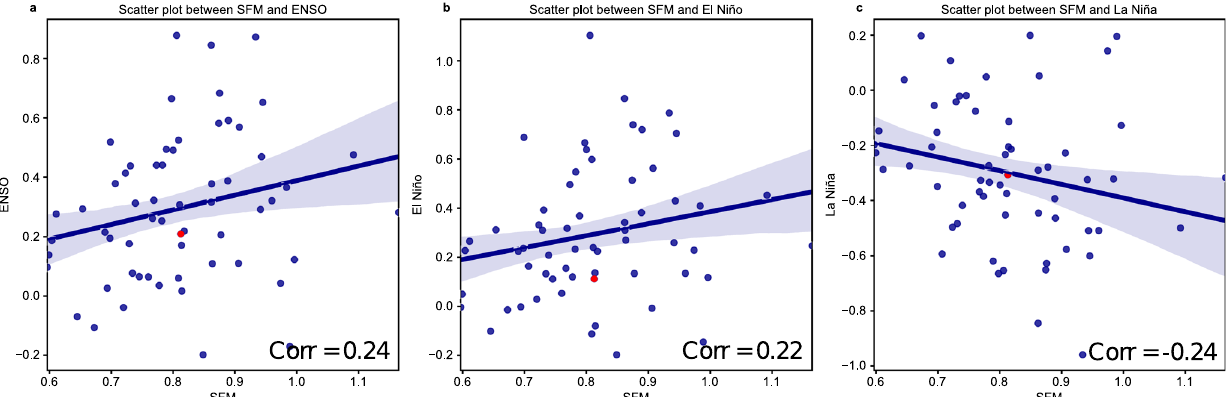
Fig. 11 Intermodel relationship between Niño3.4 index and SFM index for selected NPO events. a Scatter plot of the SST anomalies over Niño3.4 region and the SFM computed for the differences between positive and negative NPO phases. b Same as ( a ) but only for all positive NPO phases. c Same as ( b ) but for all negative NPO phases. Linear regression lines are shown with their 90% con fi dence intervals (shaded) tested by the bootstrap method. The correlation coef fi cients are 0.24, 0.22, and − 0.23, respectively for ( a ), ( b ), and ( c